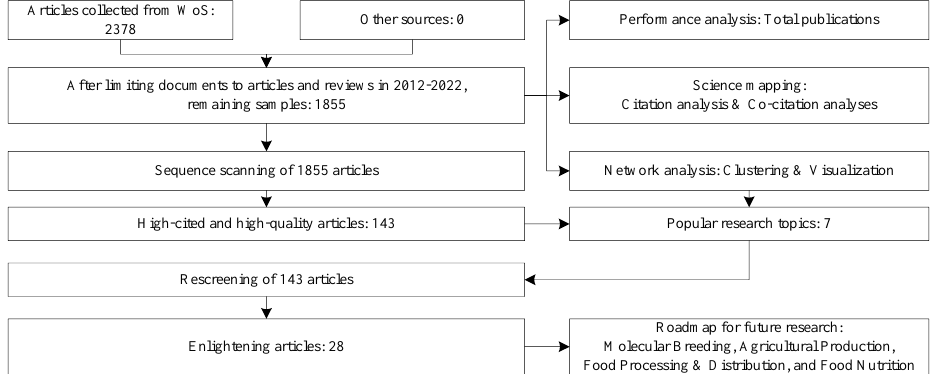
Figure 1. Framework of the article retrieval process and the overall research process.